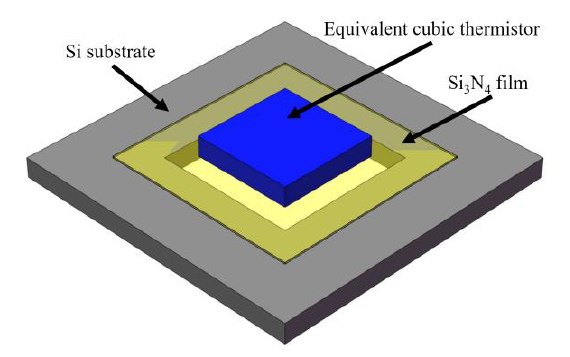
Table 2. The simulated result about P 1 , T, and ΔT = T - 0.12. G 1 ≈ 2 × 10 -6 W/K was fitted by those